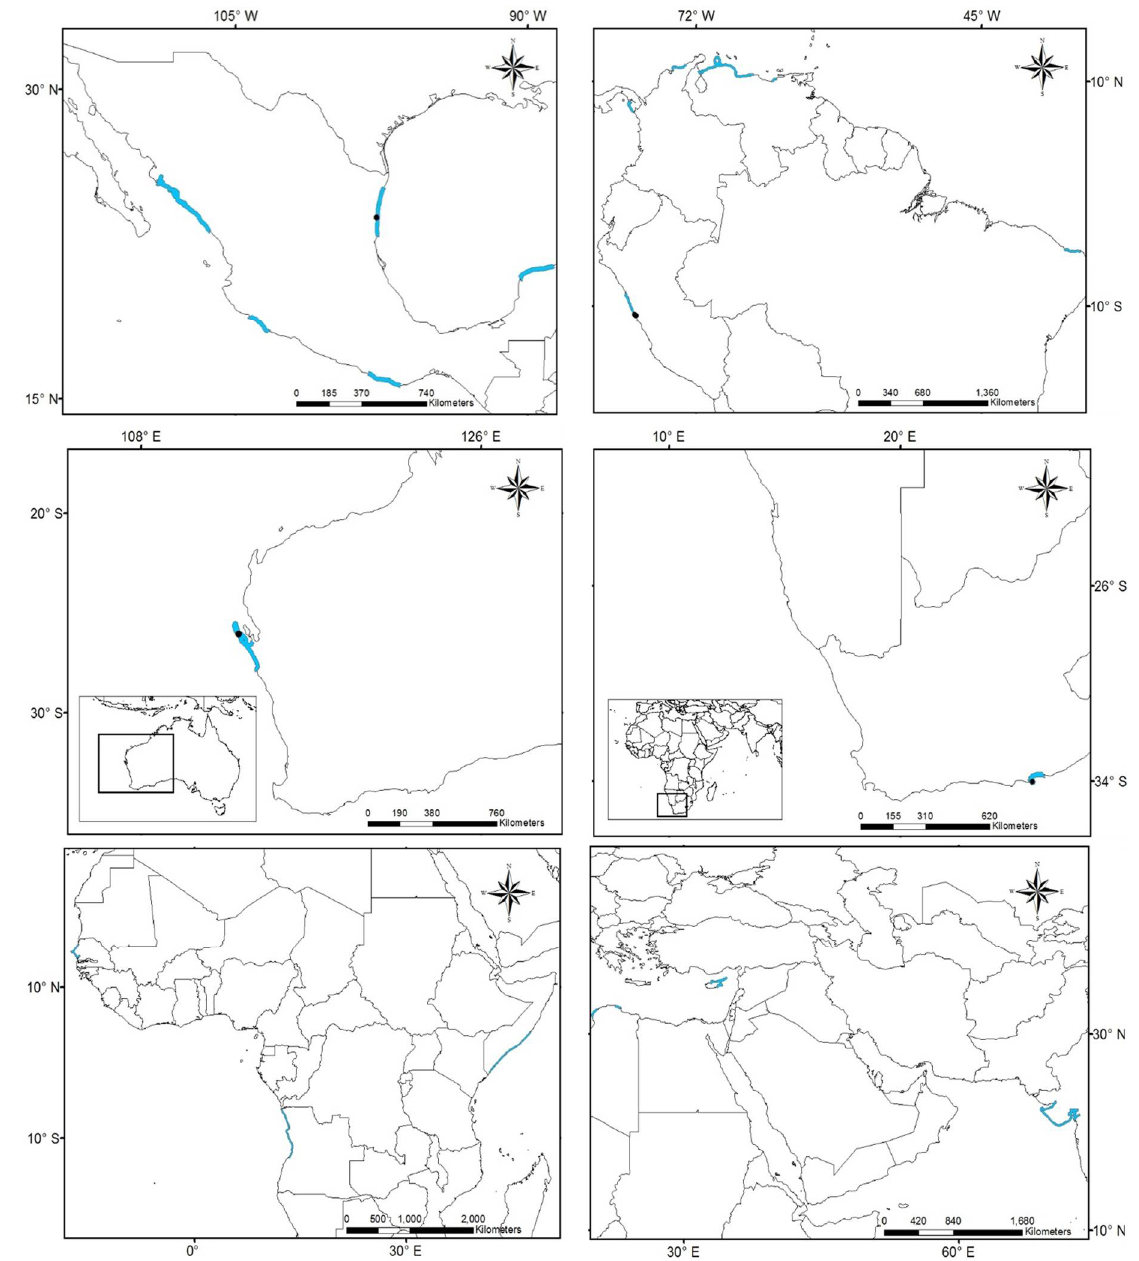
Figure A3. Training (blue) areas for the construction of the models corresponding to hot semi-arid climate (Bsh). Black dots represent occurrence records.